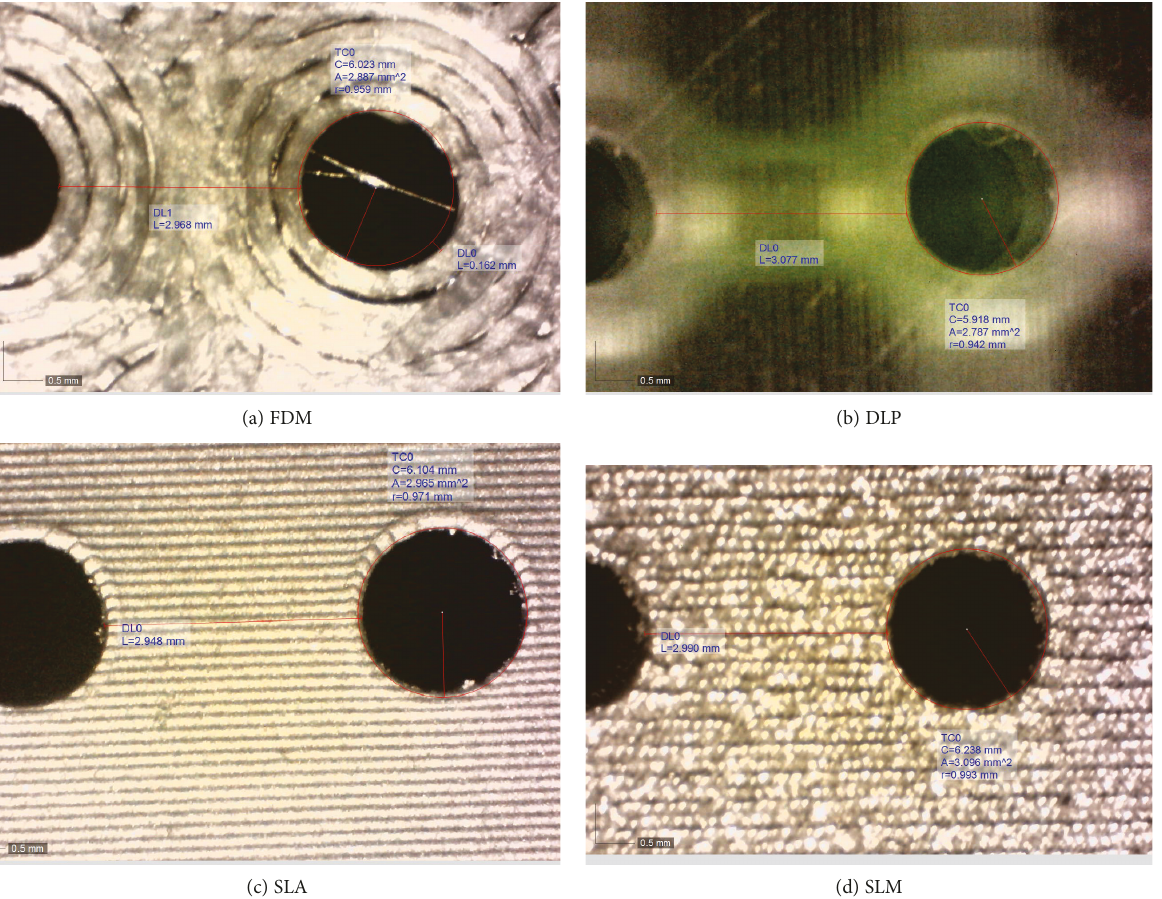
Figure 4: Microscopy images detailing the dimensional accuracy of the 3D print